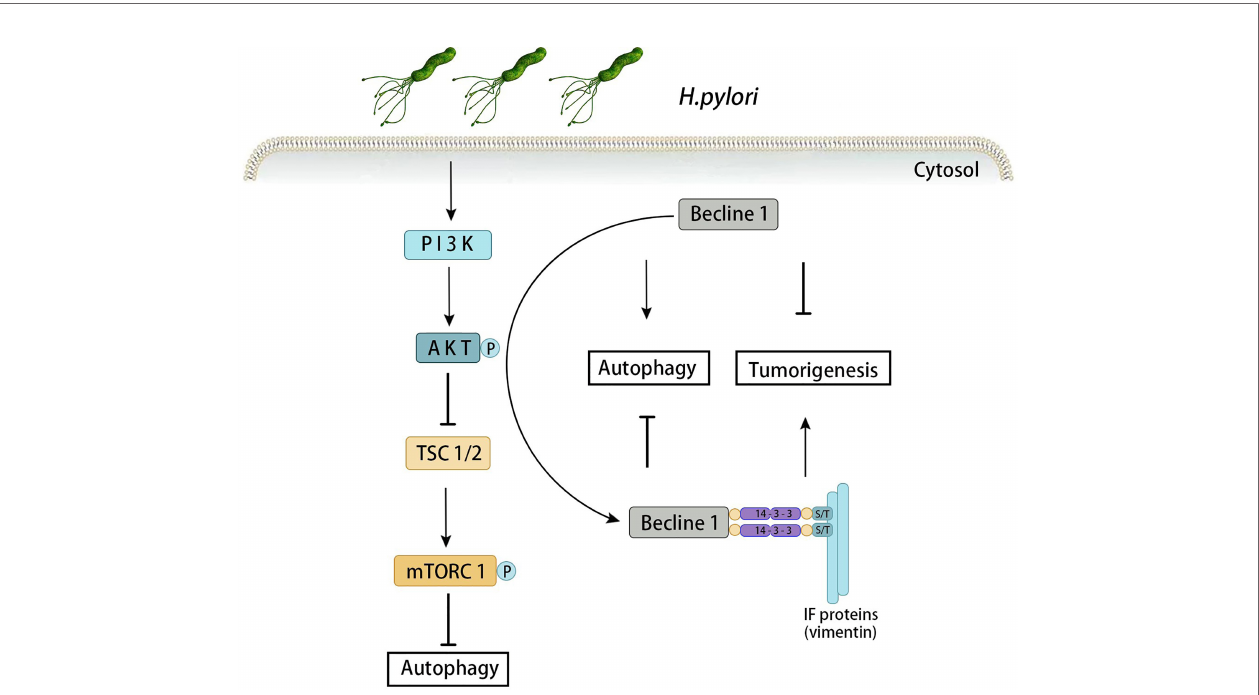
FIGURE 2 | Autophagy induced by PI3K-Akt-mTOR signaling pathway in H. pylori -associated gastric cancer. When infected with H. pylori , Akt mediates beclin-1 phosphorylation, which activates the autophagy system, increases Vimentin and 14-3-3 protein simultaneously. Increase the expression of Vimentin can induce autophagy, and then promote the Akt-induced carcinogenesis. When Beclin-1 gene is mutated, autophagy can still be activated via PI3K-Akt-mTOR if Akt-mediated phosphorylation